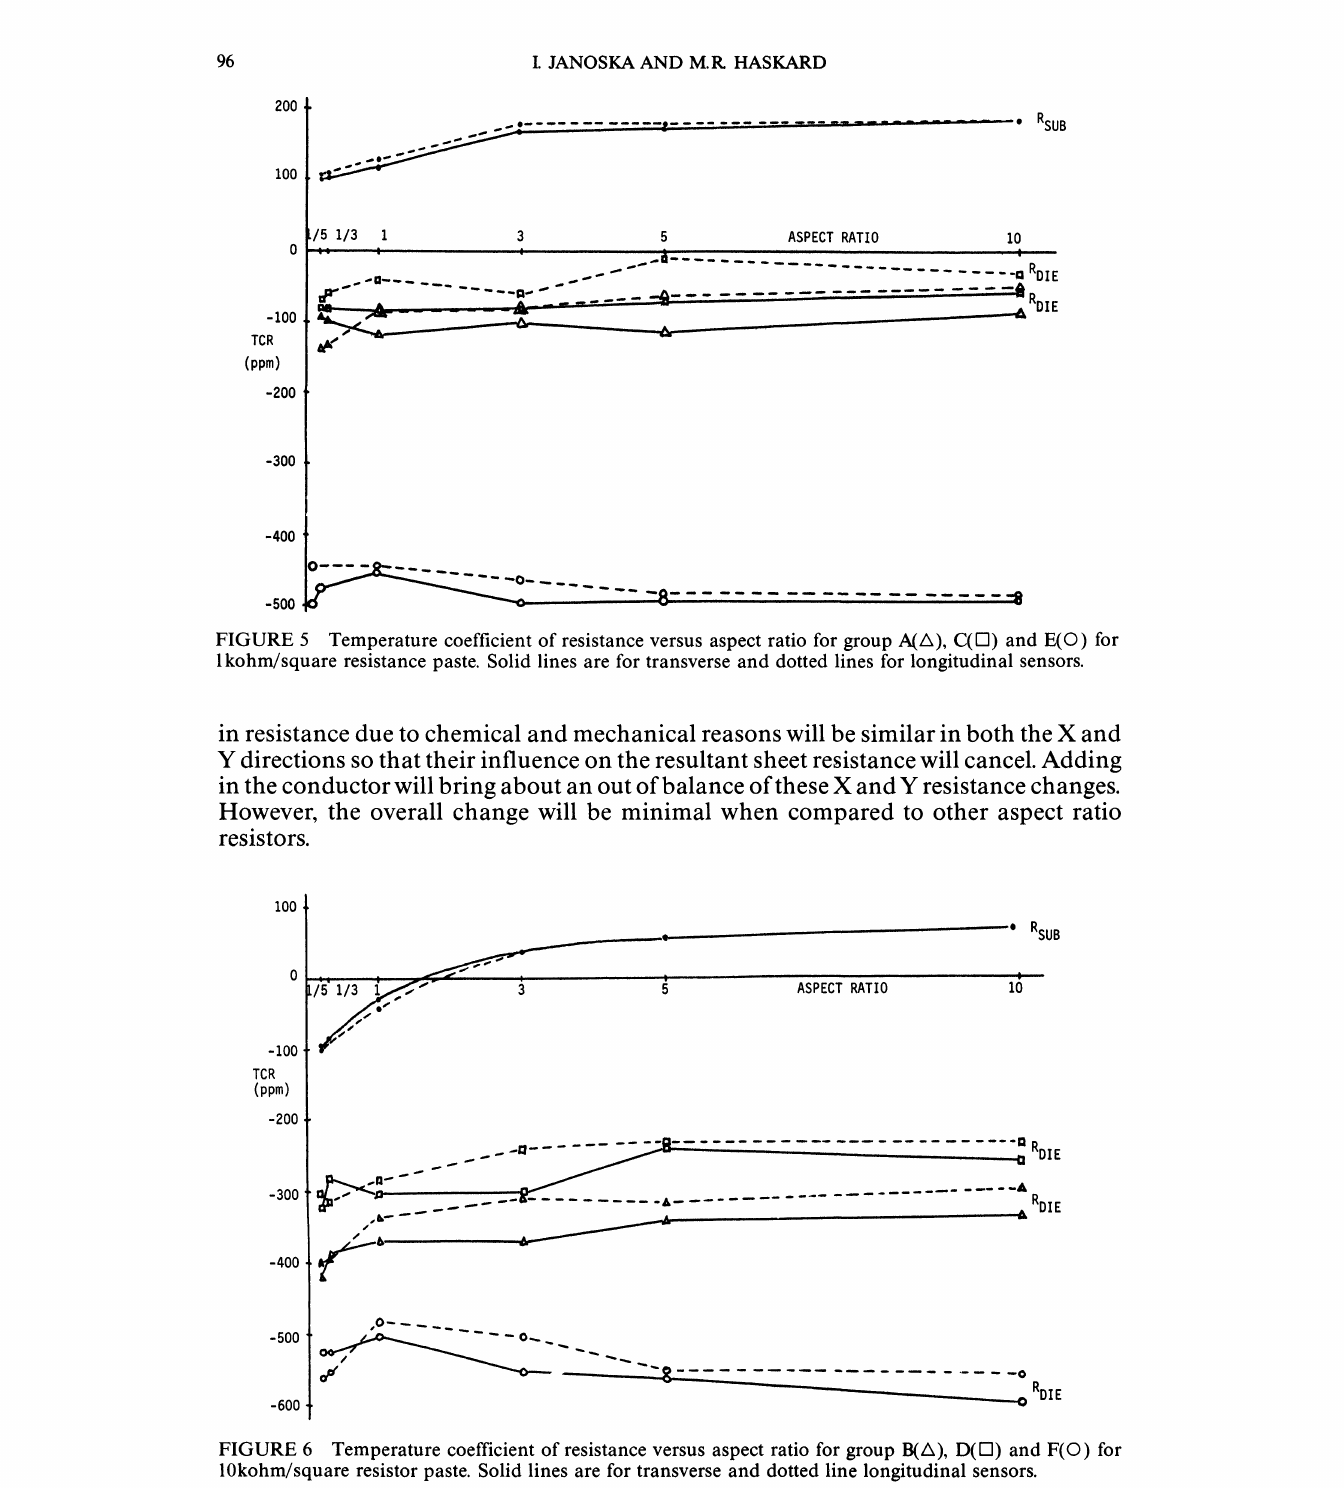
FIGURE 6 Temperature coefficient of resistance versus aspect ratio for group B(A), D(D) and F((C)) for 10kohm/square resistor paste. Solid lines are for transverse and dotted line longitudinal